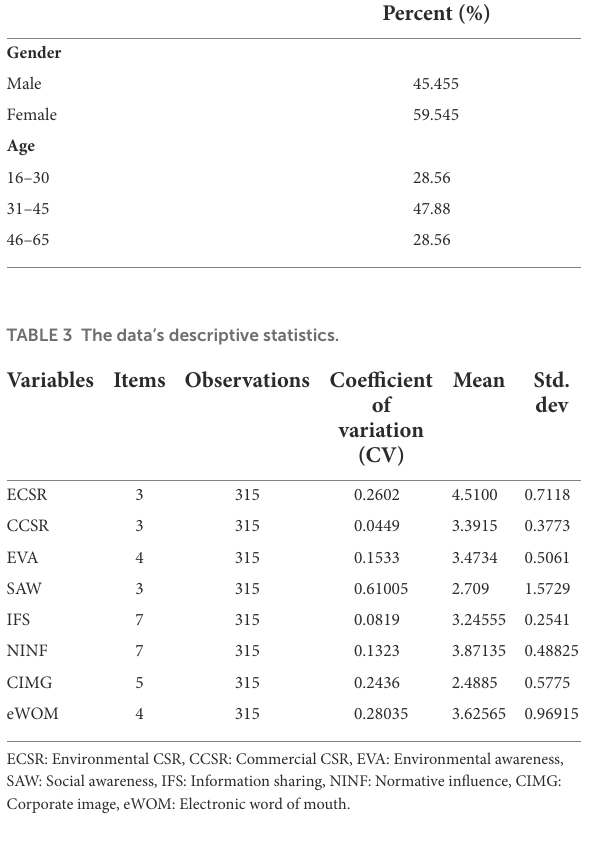
TABLE 2 Demographic of the sample.